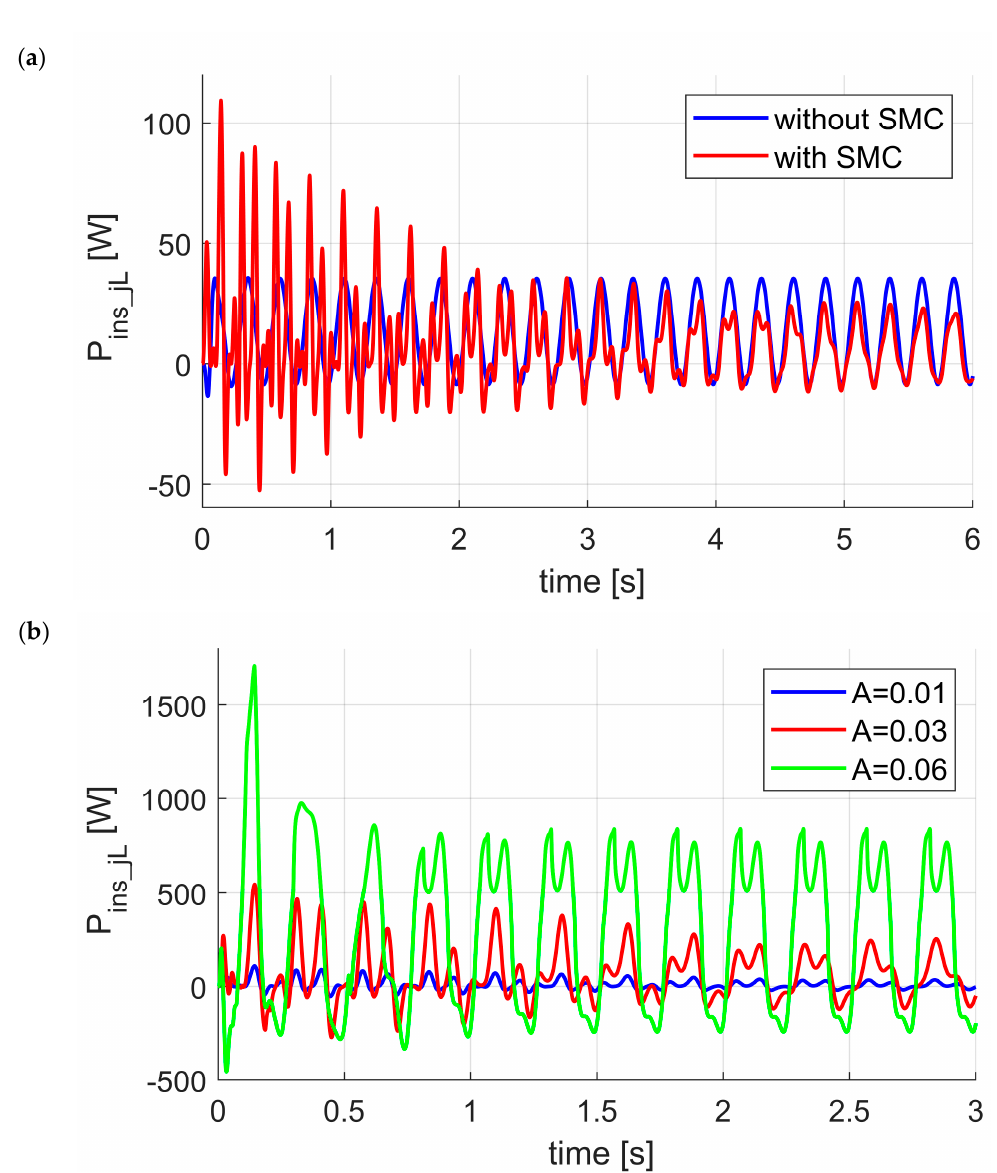
Figure 11. Comparison of strut actuator power consumptions with and without SMC controller for excitation parameters (cid:1827) (cid:3050)_(cid:3037)(cid:3019) = (cid:1827) (cid:3050)_(cid:3037)(cid:3013) = 0.01 m,(cid:1858) (cid:3050)_(cid:3037)(cid:3019) = (cid:1858) (cid:3050)_(cid:3037)(cid:3013) = 2 Hz ( a ) and comparison of the left strut actuator power consumption for different excitation amplitudes ( b ).